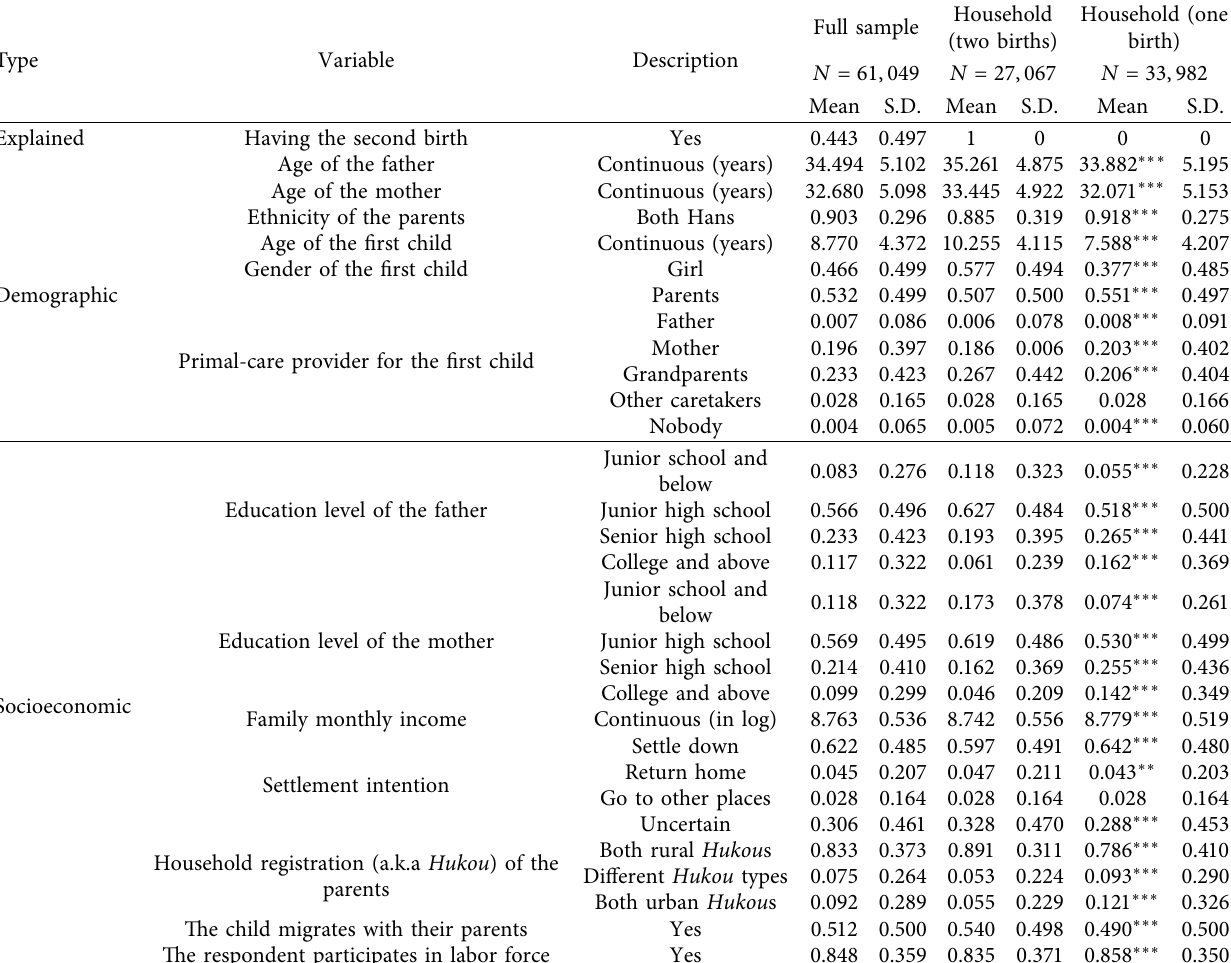
Table 1: Descriptive statistics of the used sample, which is a subset of the CMDS2016. For variables with binary values, the mean indicates the proportion of the positive